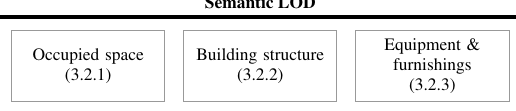
Figure 7. The three classes of semantic LOD